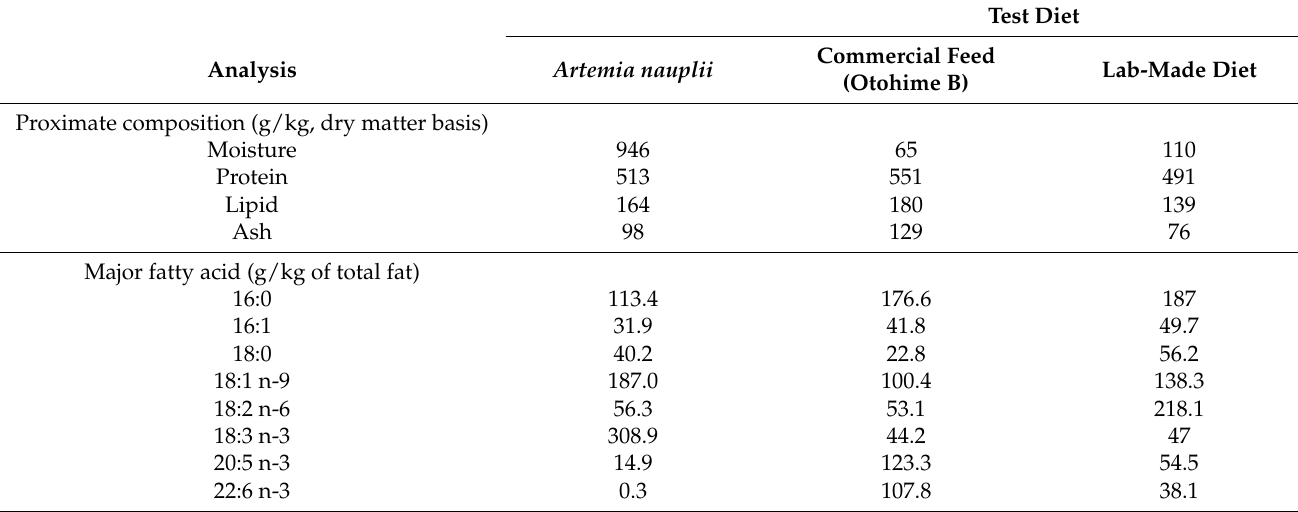
Table 2. Nutritional composition of test diets for Feeding trial